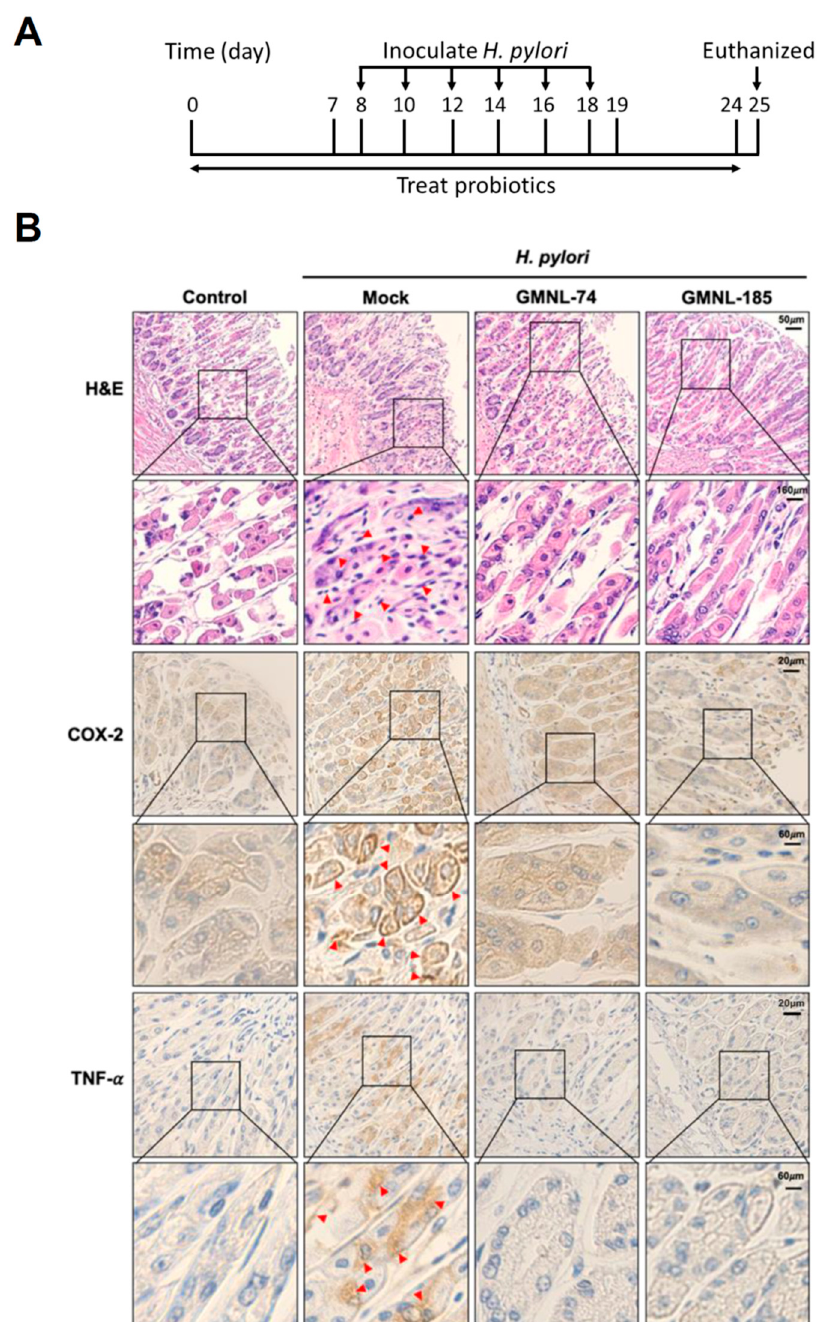
Figure 4. Probiotic Lactobacillus spp. alleviated gastric inflammation in mice. ( A ) Mice were fed with Lactobacillus spp. (GMNL-74 and GMNL-185) for 24 days followed by intragastric gavage with H. pylori 26695 once every 2 days for a total of six administrations. Arrows show the days of H. pylori inoculation. ( B ) Mice were euthanized and gastric tissues were subjected to hematoxylin–eosin (H&E) and immunohistochemical (IHC) staining with specific antibodies against cyclooxygenase-2 (COX-2) and tumor necrosis factor (TNF)- α , respectively (original magnification: 200 × ). The magnified images are shown in the lower panel of each cropped area. Severe infiltration of inflammatory cells in the gastric epithelium (H&E) and pronounced expression of COX-2 and TNF- α in gastric tissues are indicated by red arrows